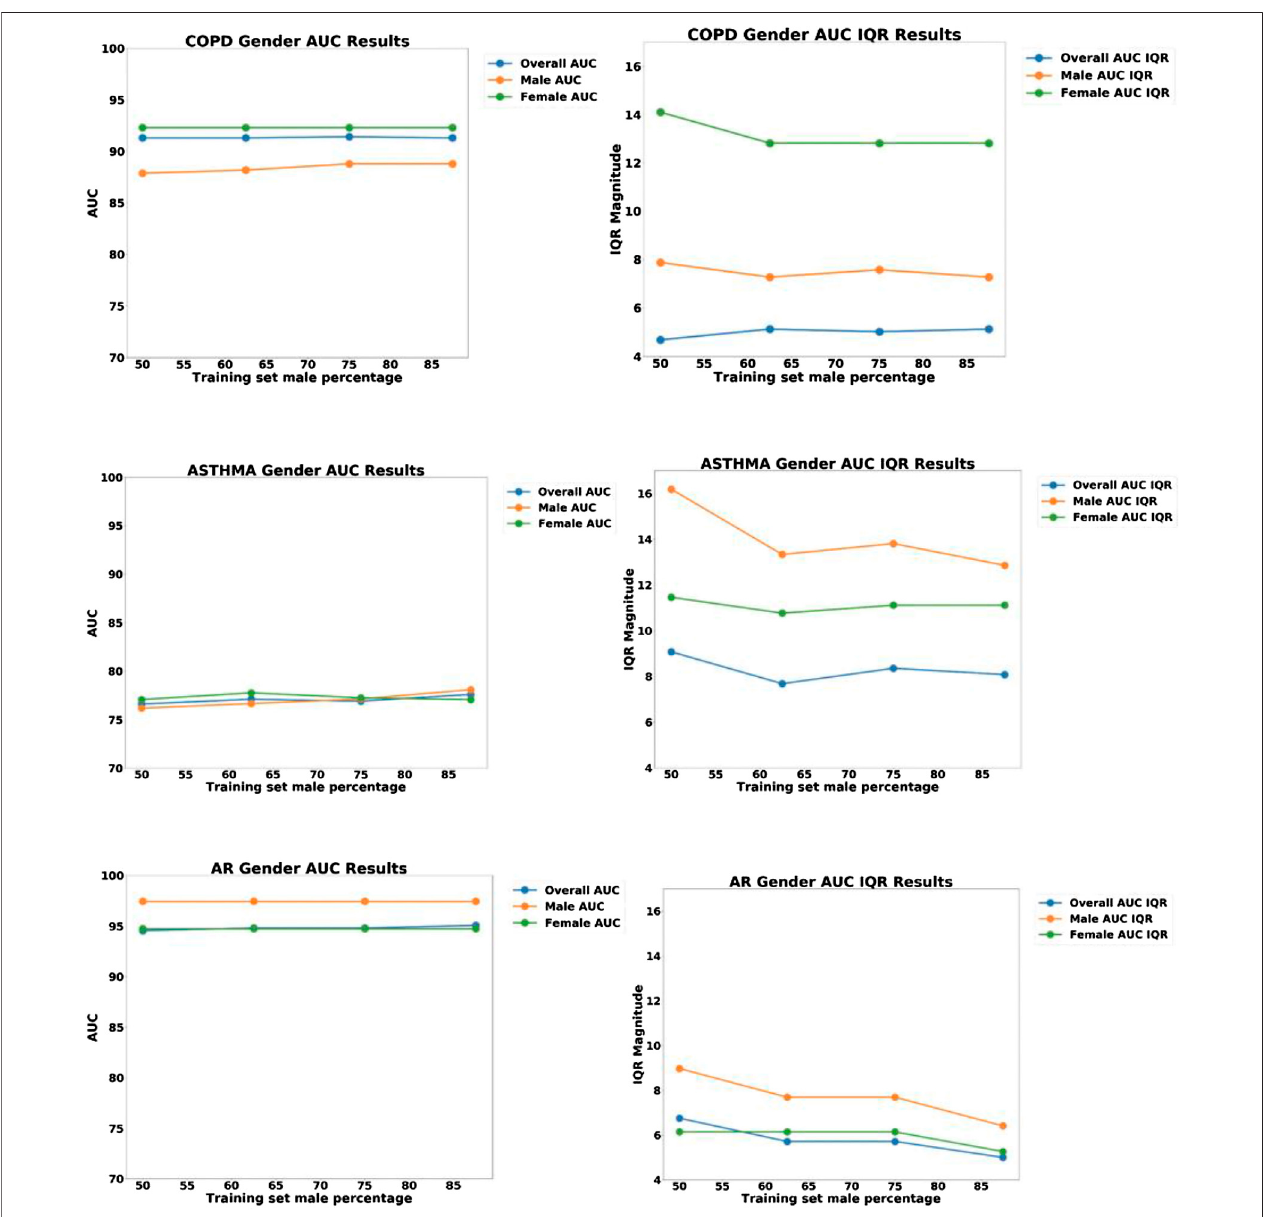
FIGURE 6 | Plots of AUC Accuracy (left) and InterQuartile range (right) results of Gender bias analysis for three different disease diagnostic models: (top) COPD; (middle) Asthma; and (bottom) Allergic Rhinitis (AR). The three colored lines in each plot represent the AUC accuracy for all groups, male only, and female only, respectively. The horizontal axis represents the proportion of males in the training set, ranging from 50to